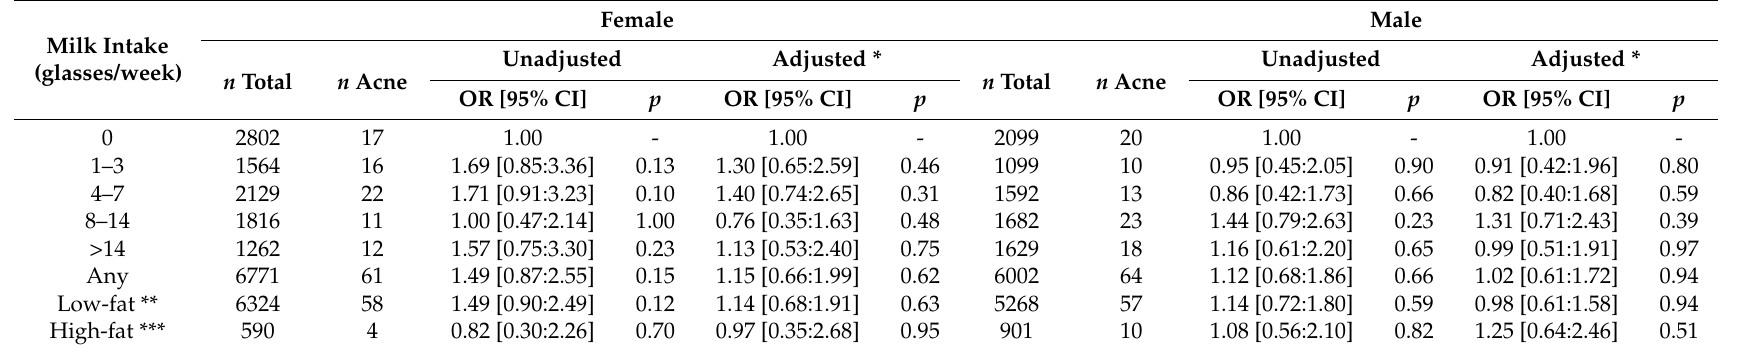
Table 3. Odds ratio for acne by milk intake for in the age group ≥ 40